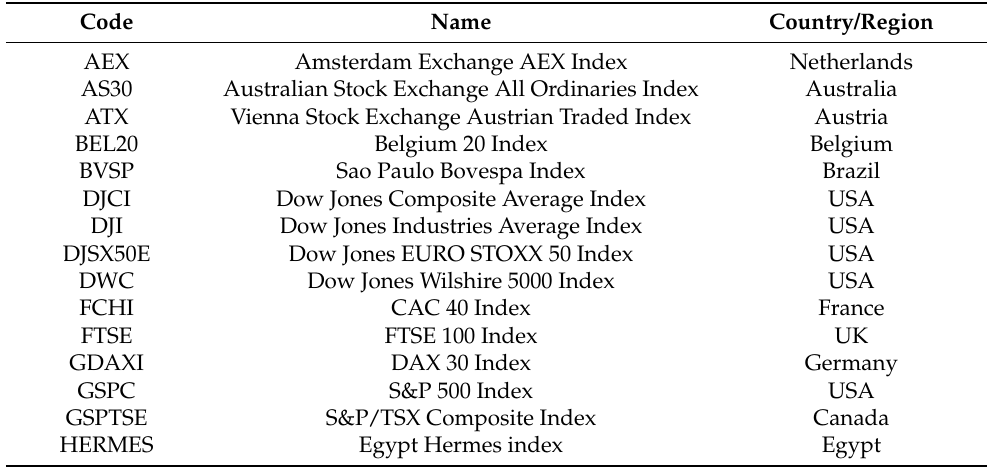
Table A2. International market indexes examined in the